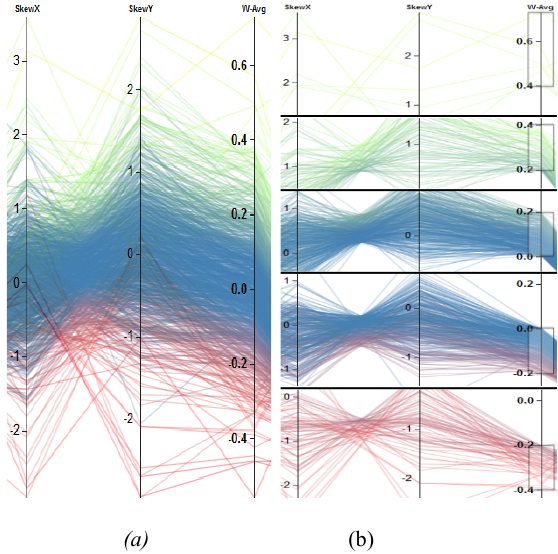
Figure 11 . The color-encoded results are shown in (a). Clus- tering was performed on the weighted average of the first two columns. Overall, a negative correlation can be recog- nized. Selecting different values ranges of the weighted average leads to the selection of subgroups of similar skew- ness values. The weights were set to 0.5 for the two metrics. All subgroups exhibit also a negative correlation. This is shown in